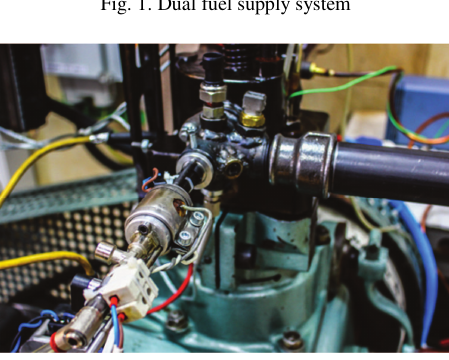
Fig. 2. Heating and fuel injection system